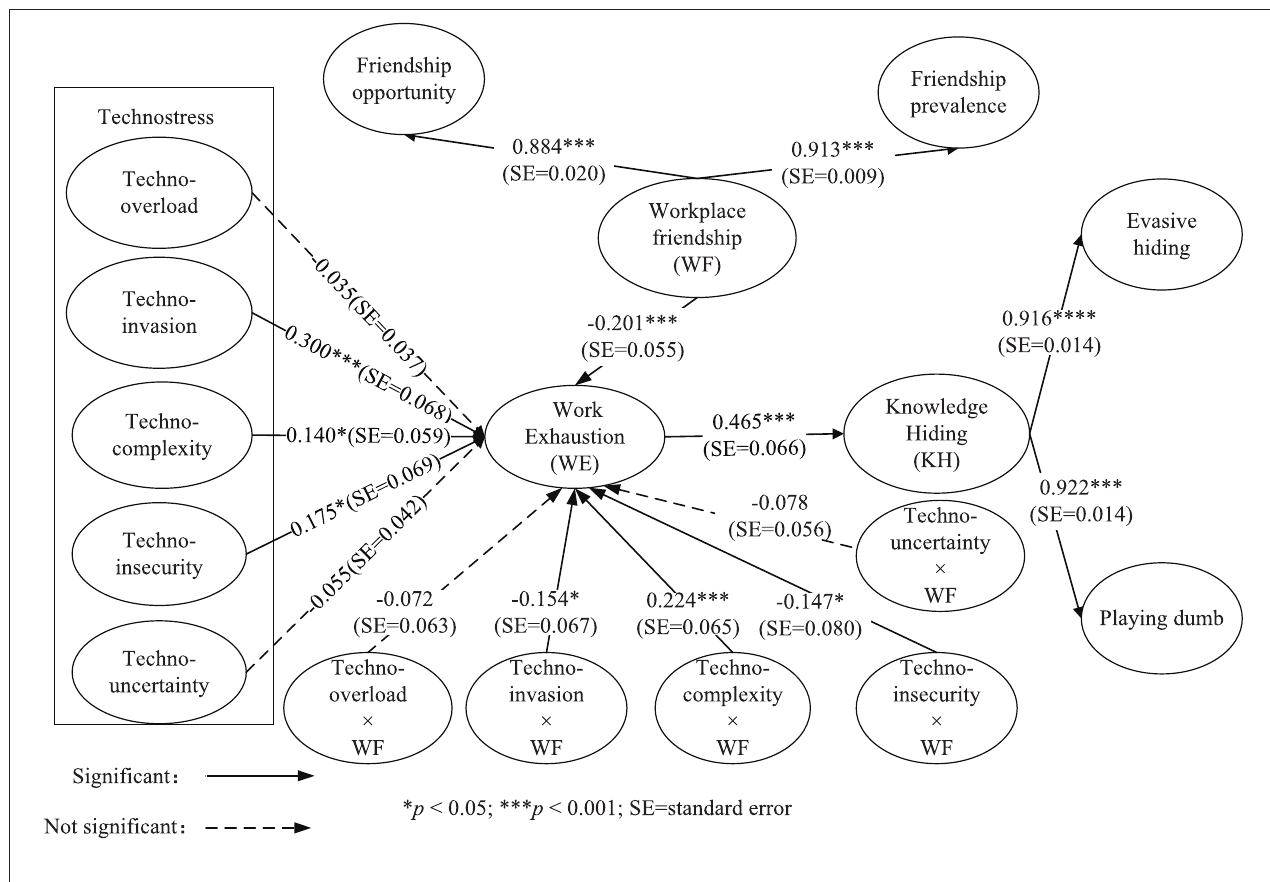
FIGURE 3 | The moderation analysis for workplace friendship ( N = 254).